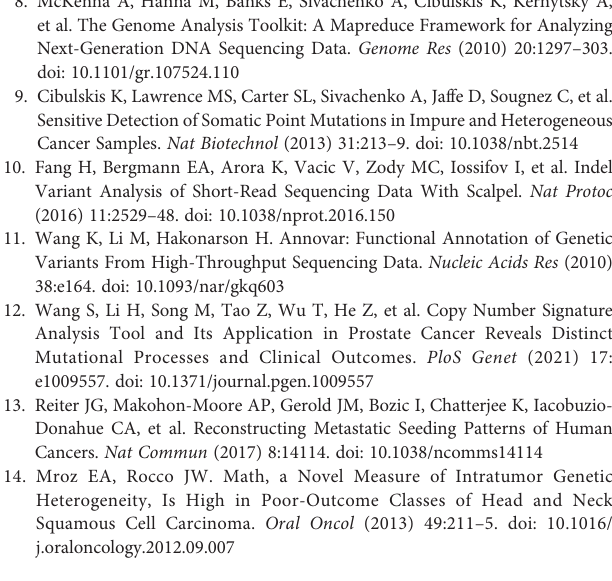
Supplementary Figure 1 | Overview of samples and study design. 18 patients, including 13 ESCC (double-primary: 8, P1-P8; single-primary: 5, P9-P13) and 5 GC patients (P14-P18). One specimen was collected from each primary tumor of ESCC, PNM of ESCC, and PNM of GC. In total, 39 tissue samples were collected and subject to WES for further comparison of their genomic alterations. Supplementary Figure 2 | Overview of mutation types inESCC PNM and tumor. (A,B) showthebasemutationpatternsinPNM andtumor ofESCC,respectively. The topand bottom panelsshow the proportionsof the changes inall samples and each sampleseparately. (C) ProportionsofdifferentSNVtypesinESCCPNMandtumor. (D) Proportionsofinactivation/non-inactivation alterationsin ESCC PNM and tumor. Supplementary Figure 3 | Overview of NOTCH1/2 mutations in ESCC PNM and tumor. (A, B) Localizations of different types of SNVs in the NOTCH1 and NOTCH2 proteins as detected in ESCC PNM and tumor. (C, D) Proportions of different types of NOTCH1/2 SNVs in ESCC PNM and tumor. Supplementary Figure 4 | Box plots showing the weights of mutation signatures corresponding to the mutations identi fi ed in ESCC PNM and tumor. Note that the APOBEC signature is signi fi cantly different between PNM and the tumor. Supplementary Figure 5 | Comparison of GC and ESCC samples. (A) Details of geneticalterationtypeanddistributioninthe fi veGCPNMsamples. (B) Comparison of mutation numbers per sample in ESCC tumor and PNM, as well as GC PNM. (C) The proportions of patients carrying mutations in the signaling pathway-related genes between GC and ESCC samples. Note that the frequency of the TP53 signaling pathway is signi fi cantly lower in GC PNM. Table S1 | Baseline characteristics of non-ESCC (gastric cancer) patients enrolled in this study. Table S2 | Mutations shared in PNM and tumor samples of ESCC. Table S3 | TP53 somatic mutations detected in all ESCC